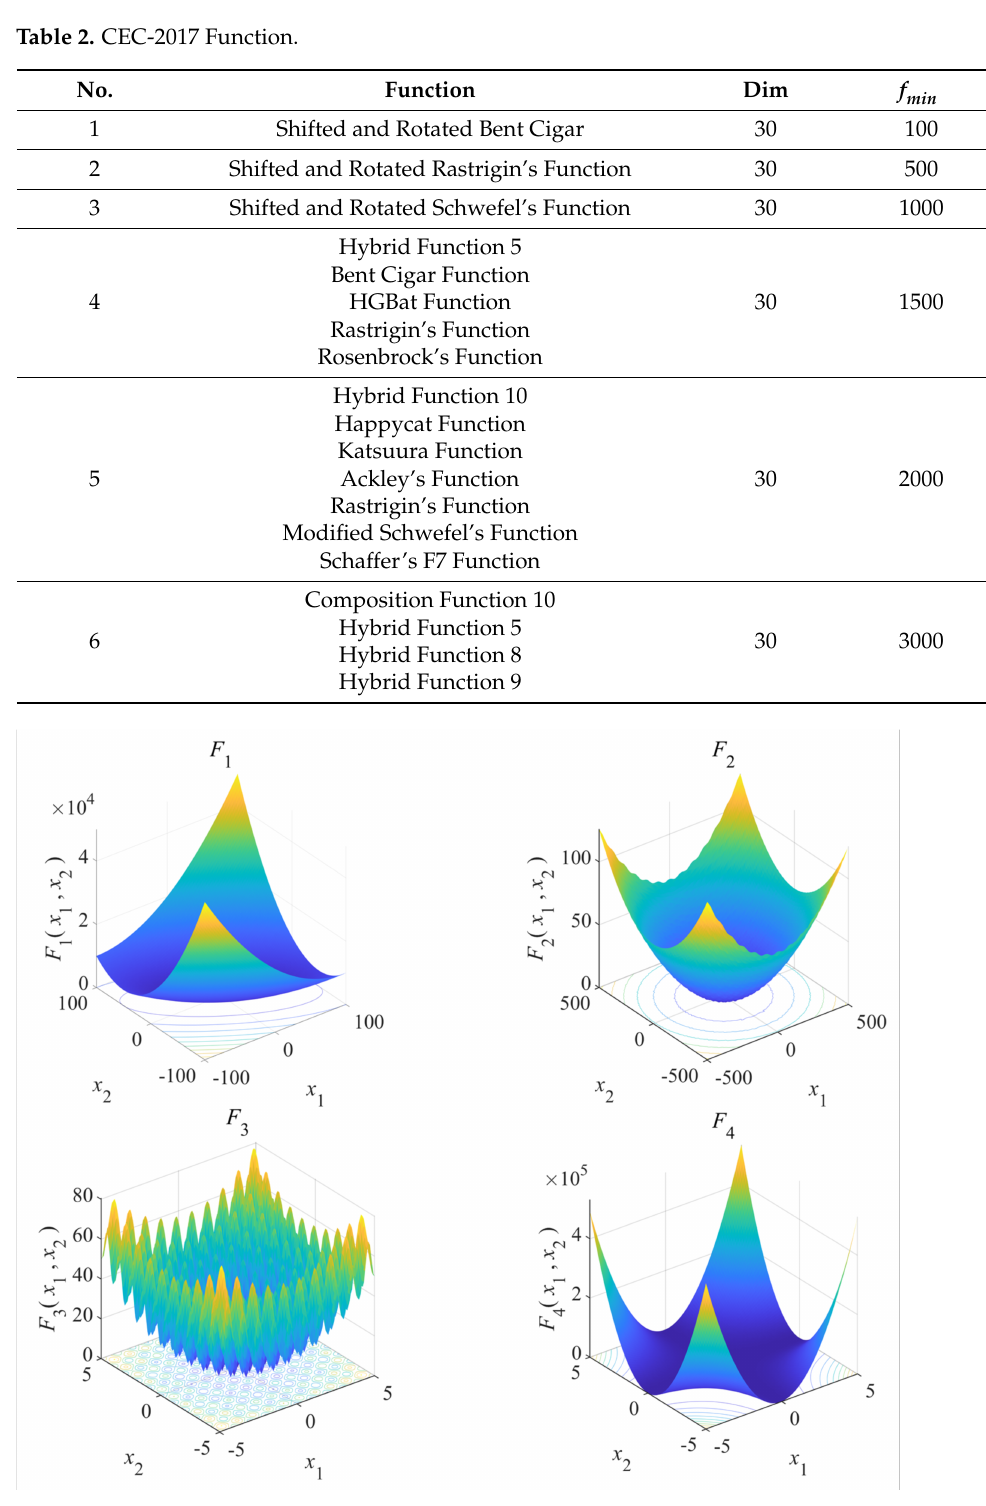
Figure 5. Three-dimensional diagram of benchmark